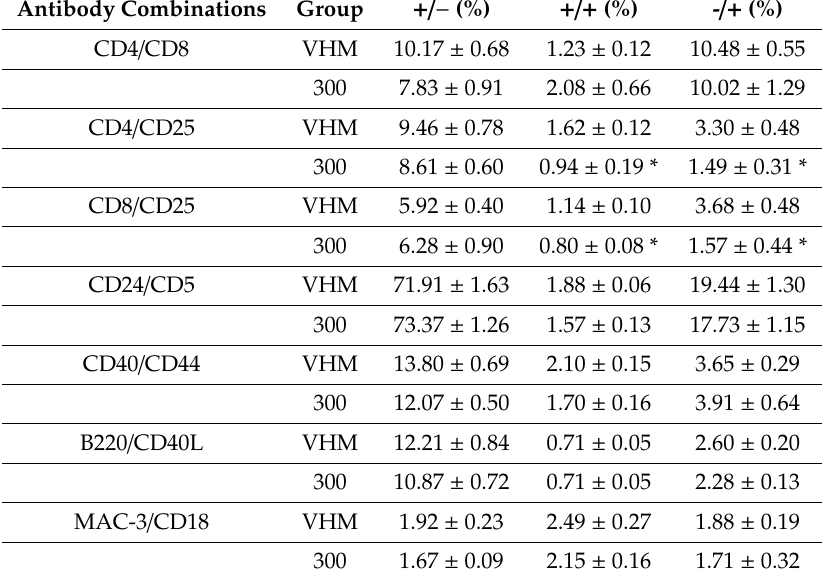
Table 3. Percentages of splenic immune cell populations in male NOD mice initially on a phytoestrogen-free diet for 70 days and then switched to the soy-based diet for another 31 days.